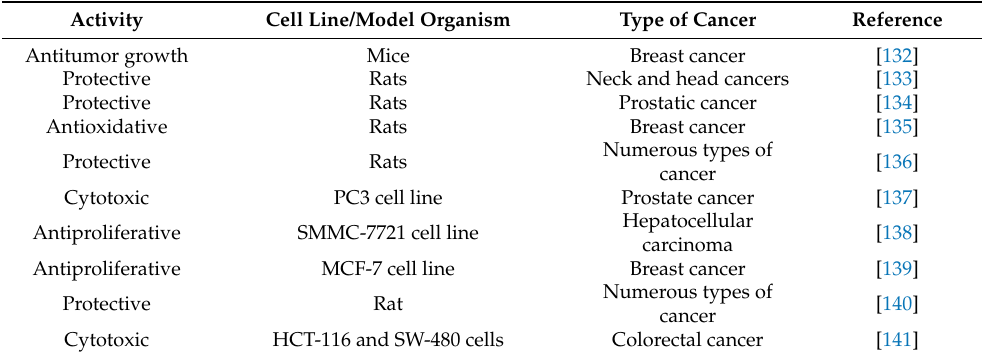
Table 2. The anticancer activity and protective effect of RJ against cancer treatments on different model